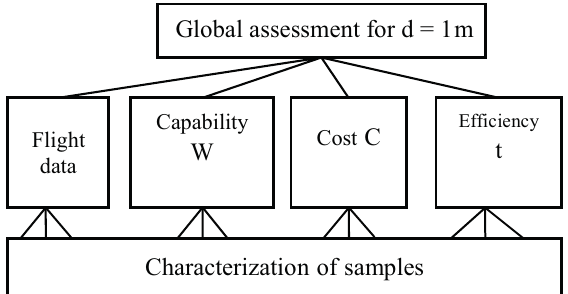
Fig. Structural diagram for determining global